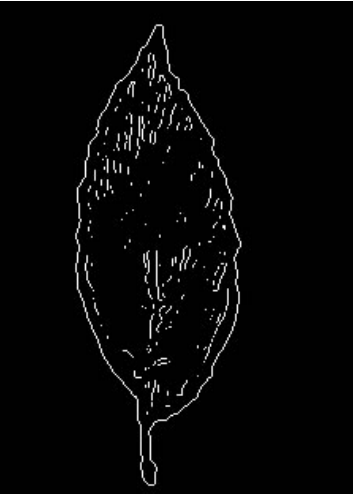
Figure 3. Edge detection of a tobacco leaf using Laplacian of Gaussian filtering.